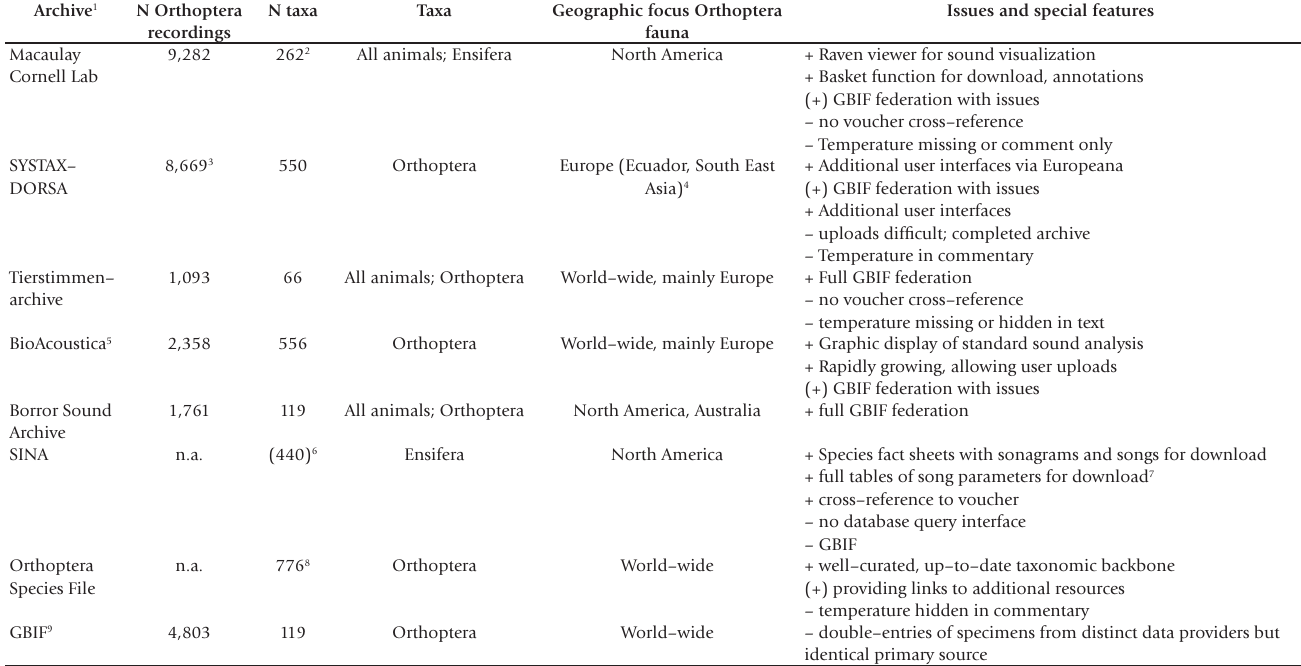
Table 1. Digitized Orthoptera songs in major sound archives and databases. For further details on issues and special features see